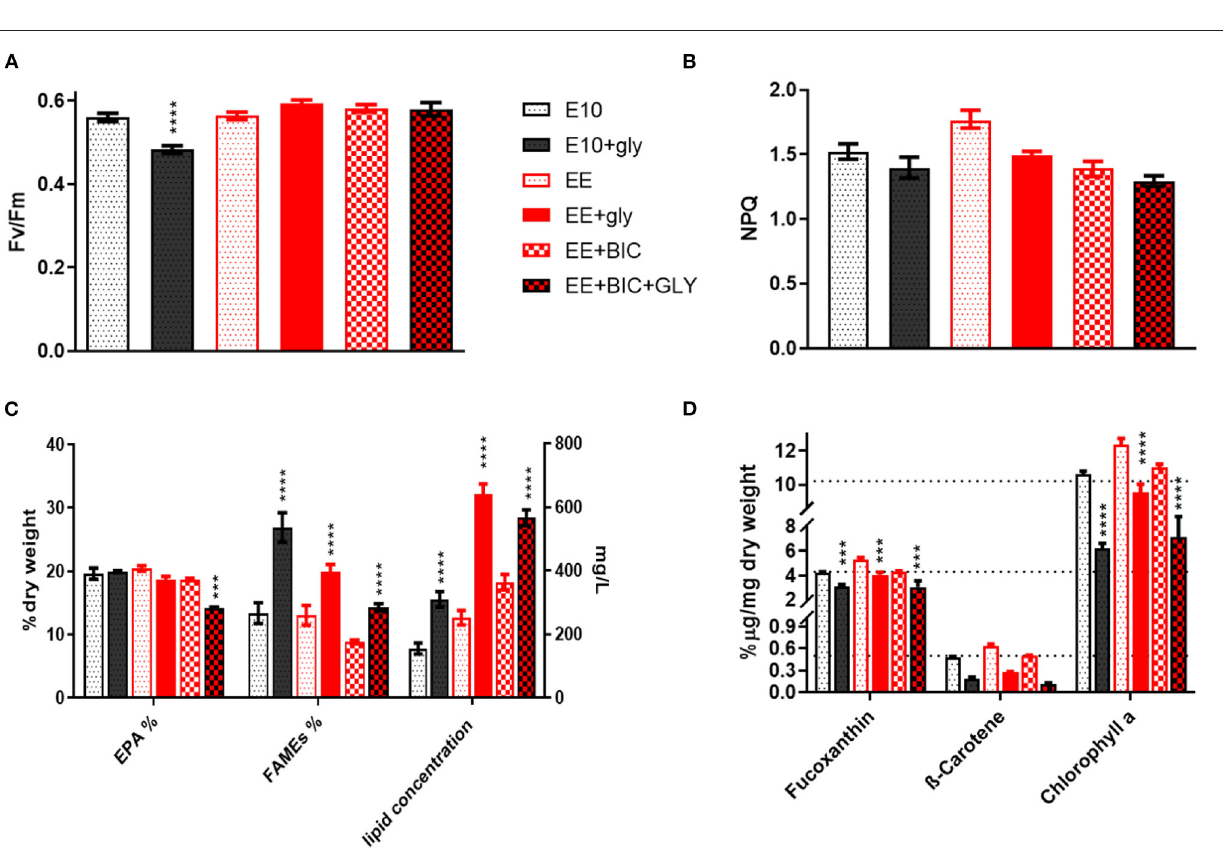
FIGURE 3 | Biomass analysis and photosynthetic parameters analysis. (A) Fv/Fm and (B) NPQ measurement, (C) Lipids, and (D) pigments analysis in the initial medium E10 and in the optimized medium EE and EE+BIC in both mixotrophy and phototrophy. In (C) , right Y-axis (mg/L) is for lipid concentration while the left Y-axis(%) is for FAMES and EPA. One-way analysis of variance (ANOVA) test was applied in order to compare the phototrophy and mixotrophy in different media. Data were considered significant for p -values (**** p < 0.0001) and (*** p < 0.001). Each point expressed as mean ± stdev ( n = 4). E10, ESAW 10XN,P; EE,